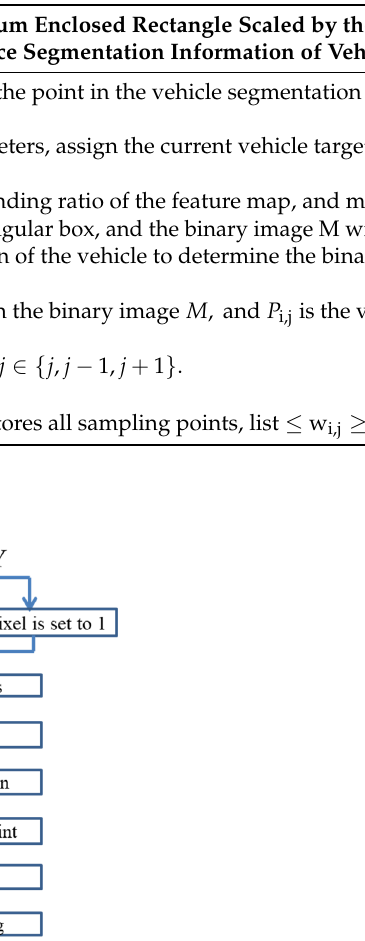
Table 1. The operation flow of accurate area point sampling.